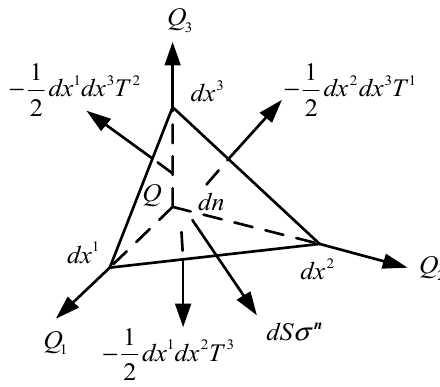
Figure 2. Forces on a tetrahedron.